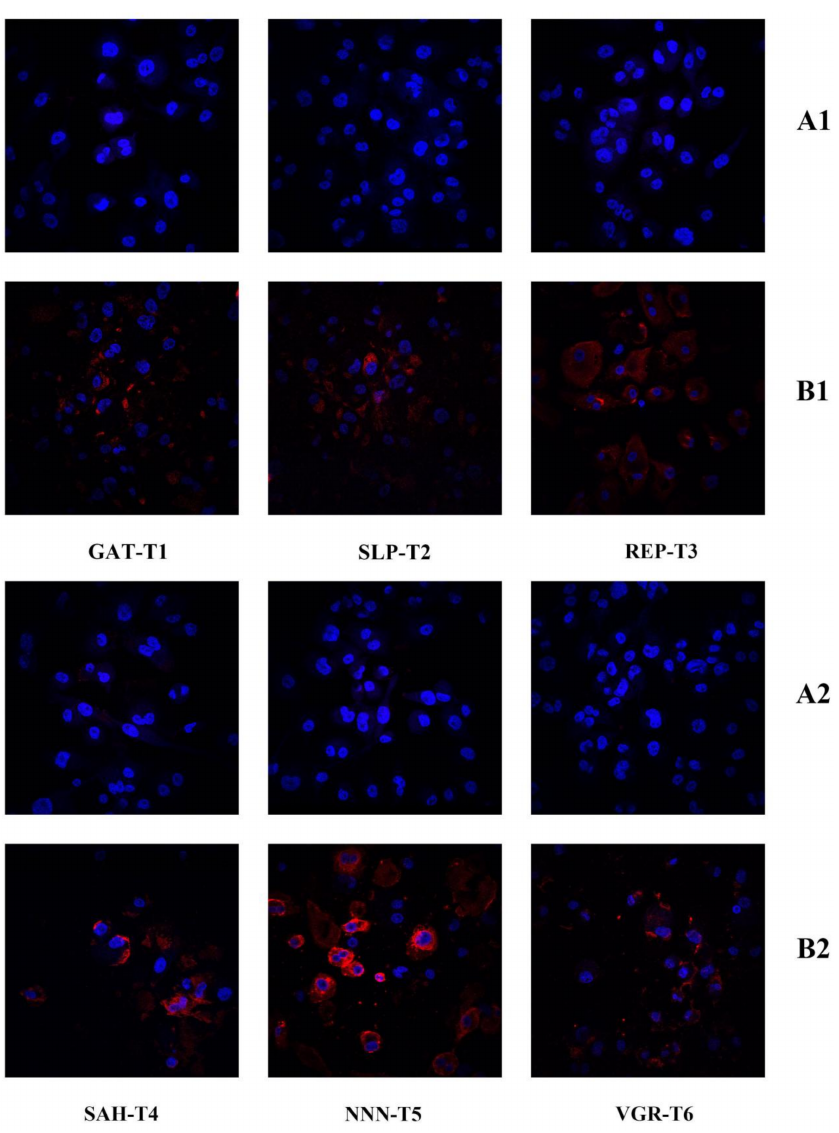
Figure 8. The confocal images of THP-1 and foam cells, both THP-1 ( A1 and A2 rows) and foam cells ( B1 and B2 rows) were treated with DAPI and avidin-conjugated